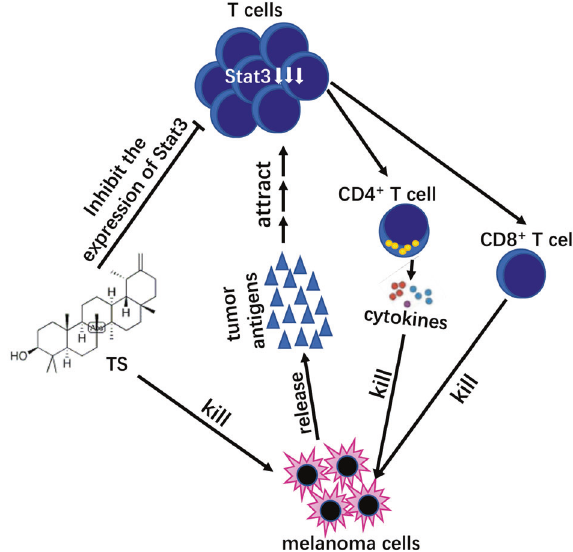
Fig. 6 Hypothesis of the mechanism about TS anti HCC. The high expression of STAT3 will not only signi fi cantly promote tumor progression, but also mediate tumor immune escape, and the results further con fi rmed that TS could signi fi cantly inhibit the expression of STAT3 protein in tumor tissues. Therefore, we hypotheses that the anti-tumor mechanism of TS is as follows: fi rstly, TS causes the apoptosis of tumor cells, which would enable tumor cells to release more tumor antigens, chemotactic a large number of CD4 + and CD8 + T lymphocytes to reach tumor tissues and play an anti-tumor role. In addition, TS could inhibit the expression of STAT3 protein in T cells and further enhance the anti- tumor effect of T cells, and fi nally improve the anti-tumor immune response of tumor bearing